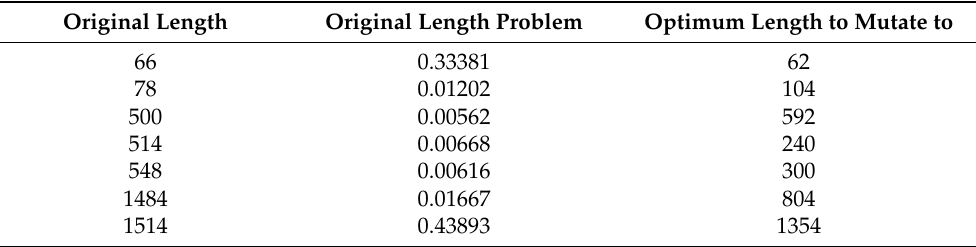
Table 10. Sample of length mapping of YouTube app, using OPriv.